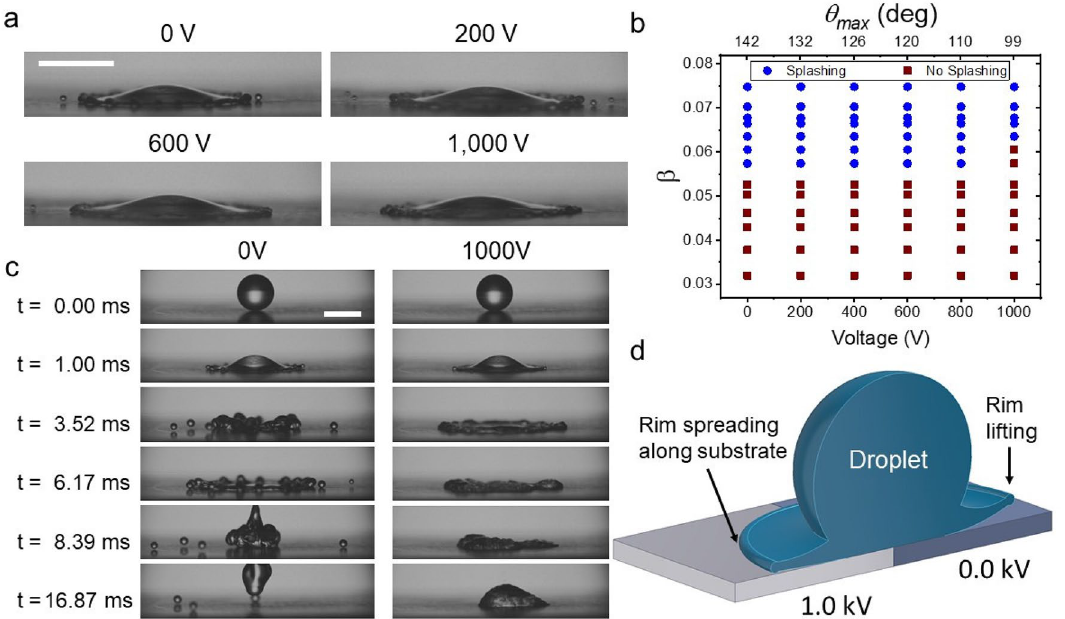
Figure 3. ( a ) Droplet snapshots, at We = 104 and t = 2.69 ms after impact. This time corresponds to the onset of splashing for 0 V but the behaviour is changed by the dielectrowetting potential. ( b ) Splashing/no-splashing map in terms of the splashing parameter β and the dielectrowetting voltage or the dynamic contact angle. ( c ) A water droplet impacting, at β = 0.061 ( We = 118 ), dielectrowetting substrates at two potentials. Splashing is observed at 0 V but no splashing is observed at 1000 V. ( d ) Schematic of the rim behaviour: at 0 V the rim detaches and flies off the surface promoting splashing. In contrast, a dielectrophoretic potential of 1000 V causes the rim to spread over the surface inhibiting splashing. Scale size = 2.5